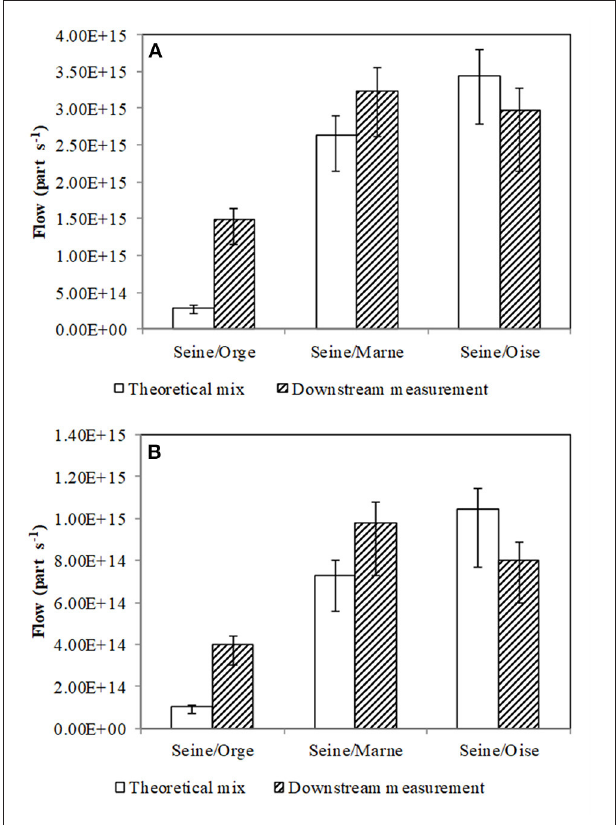
FIGURE 6 | Mass balance for the PNC of Ce (A) and of Ti (B)